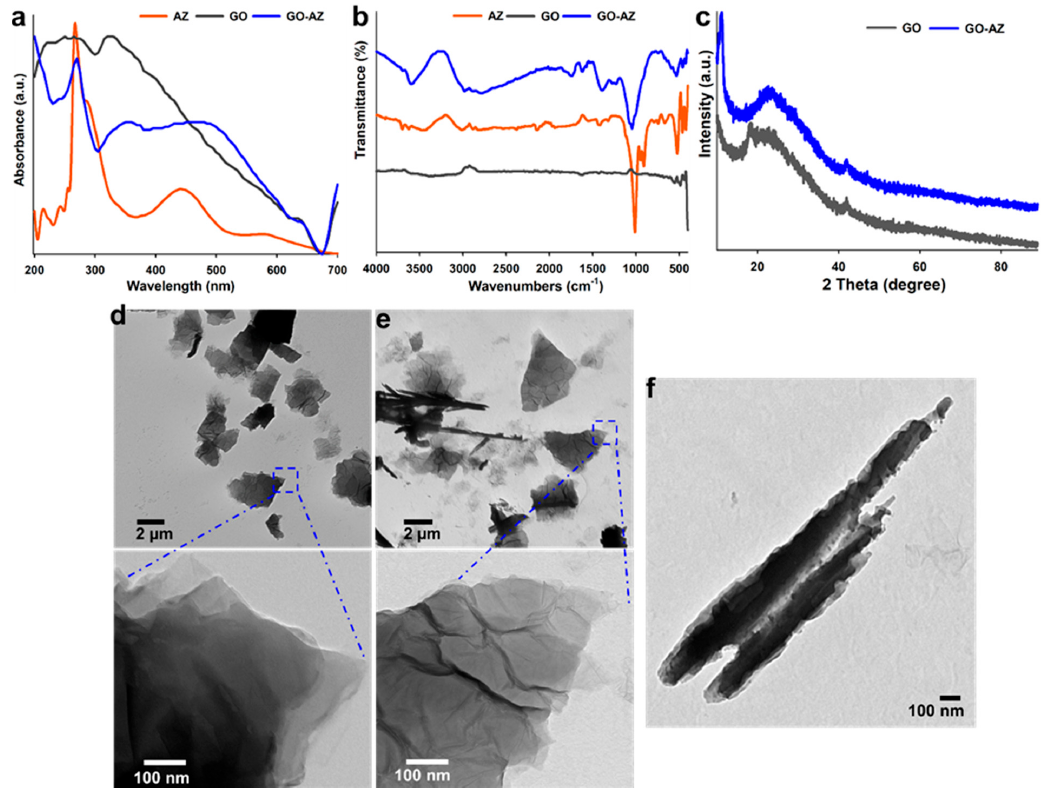
Figure 1. UV-Visible spectroscopy ( a ); FT-IR spectroscopy ( b ); and XRD patterns ( c ) of alizarin (AZ), graphene oxide (GO), and GO-AZ and TEM images ( d ) of GO and ( e ) GO-AZ: The lower panels show the magnified views of distinct surface changes on the GO before and after AZ conjugation ( f ) TEM image of fabricated GO-AZ nanoscroll. Obviously, visible layers of the rolls and increased contrast indicate the rolling of 2D sheets with a tightly wrapped AZ by the GO sheet.